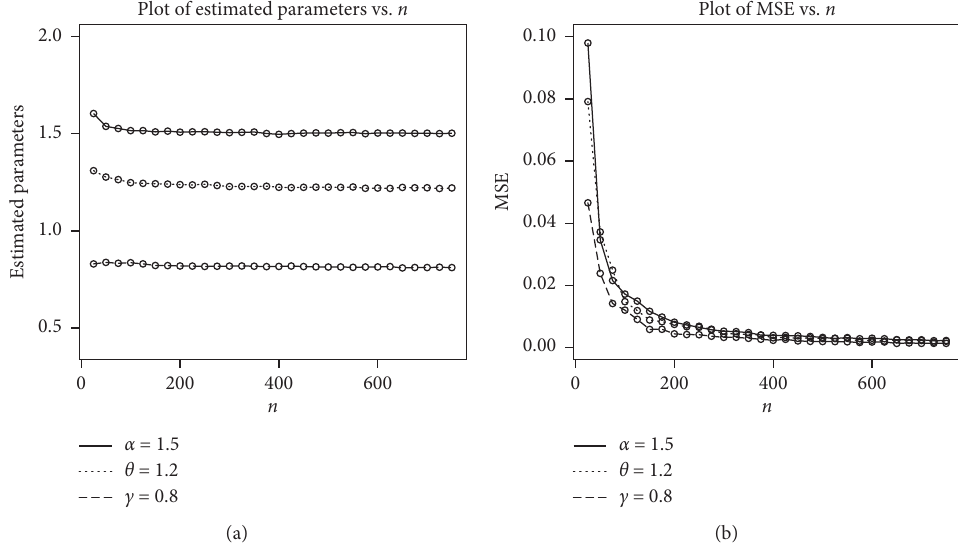
Plot of estimated parameters vs. n